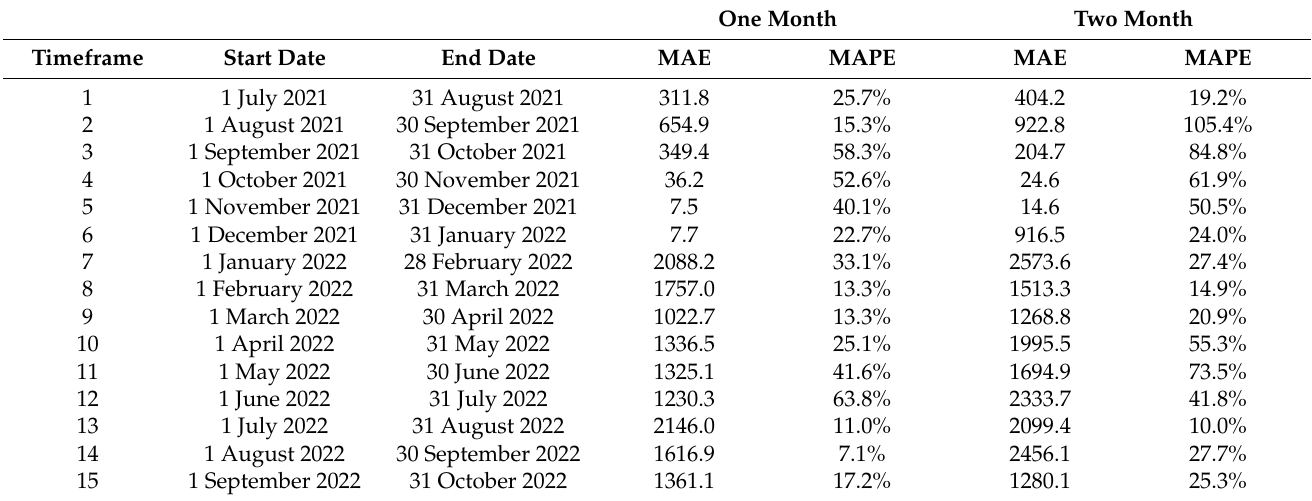
Table 2. MAEs and MAPEs across 15 timeframes of forecasting daily positive cases shown in Figure 4a before the seventh